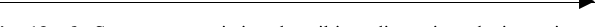
Fig. 13a–f. Summary statistics describing dispersion during winter along the two axes; X across-slope distance from the 500 m contour, and Y along-slope distance from deployment. a, b Show mean position X and Y, respectively (with confidence limits indicated by the dash-dot lines ), c, d variance in X and Y position and e, f skewness are calculated. The solid bars in a, b, c bound the two periods of high winds, days 25–40 and days 75–85, when drifters converge on the 500 m contour whilst being advected along-slope more rapidly. The fitted straight lines in variance versus time ( dot-dashed lines ) in parts c and d correspond to an average dispersion rate of 8.8 · 10 3 m 2 s –1 along-slope and 0.35 · 10 3 m 2 s ) 1 across-slope